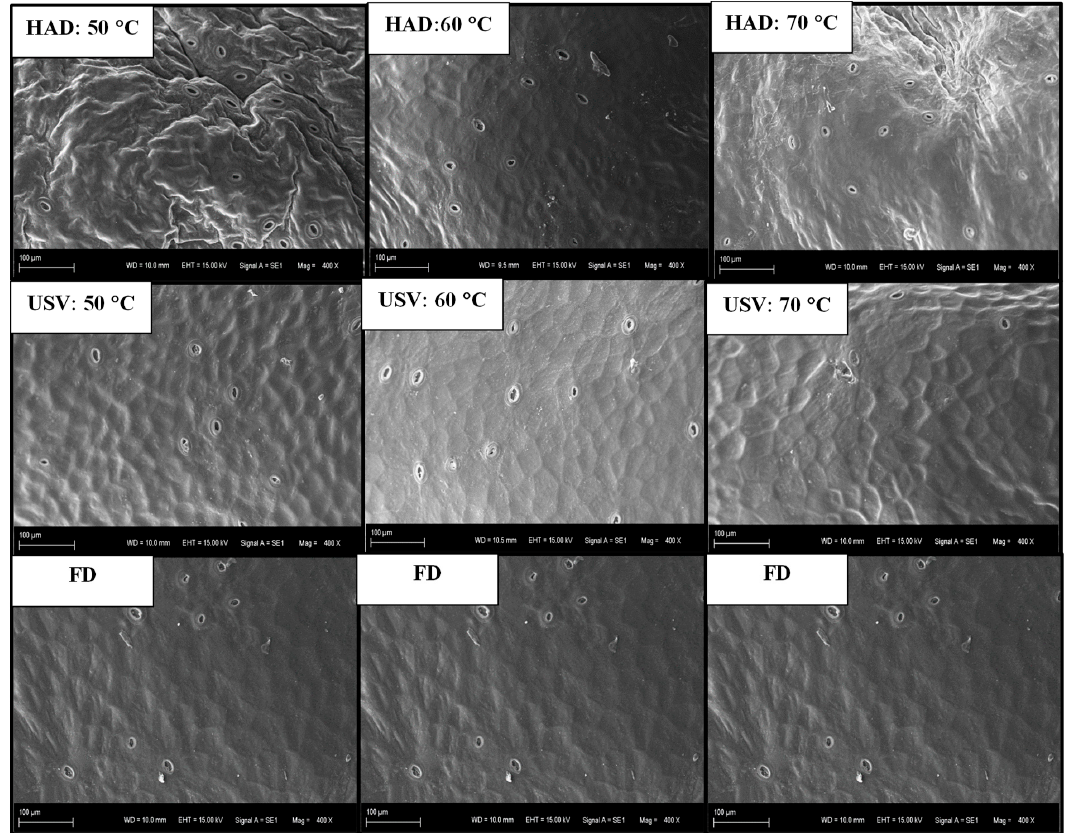
Figure 2. SEM images of the cherry laurel samples dried at different temperatures (50, 60, and 70 ℃ ) and methods (HAD, hot air drying; USV, ultrasound-assisted vacuum drying; FD, freeze-drying). Both the drying temperature and drying methods affected the shrinkage level of the samples. As can be seen from the figure, the highest shrinkage was observed in fruits dried by HAD compared to other methods. The higher shrinkage values during HAD was also reported from the previously published study [29]. The higher shrinkage could be due to a higher moisture gradient that occurred in HAD drying. The higher moisture gradient caused microstructure stress, collapsing of capillary, and irreversible structural change [30]. For HAD, application of drying temperature at 50 ℃ caused more shrinkage than those of 60 ℃ and 70 ℃ The longer drying time at 50 ℃ might have disrupted the cell wall and increased shrinkage level. HAD at 60 ℃ resulted in a lower shrinkage level than that of 70 ℃ . The optimum conditions related to both time and temperature might have resulted in lower shrinkage at 60 ℃ . The increase in temperature from 60 ℃ to 70 ℃ might have caused collapsing of the capillary structure and forming of shrinkage.